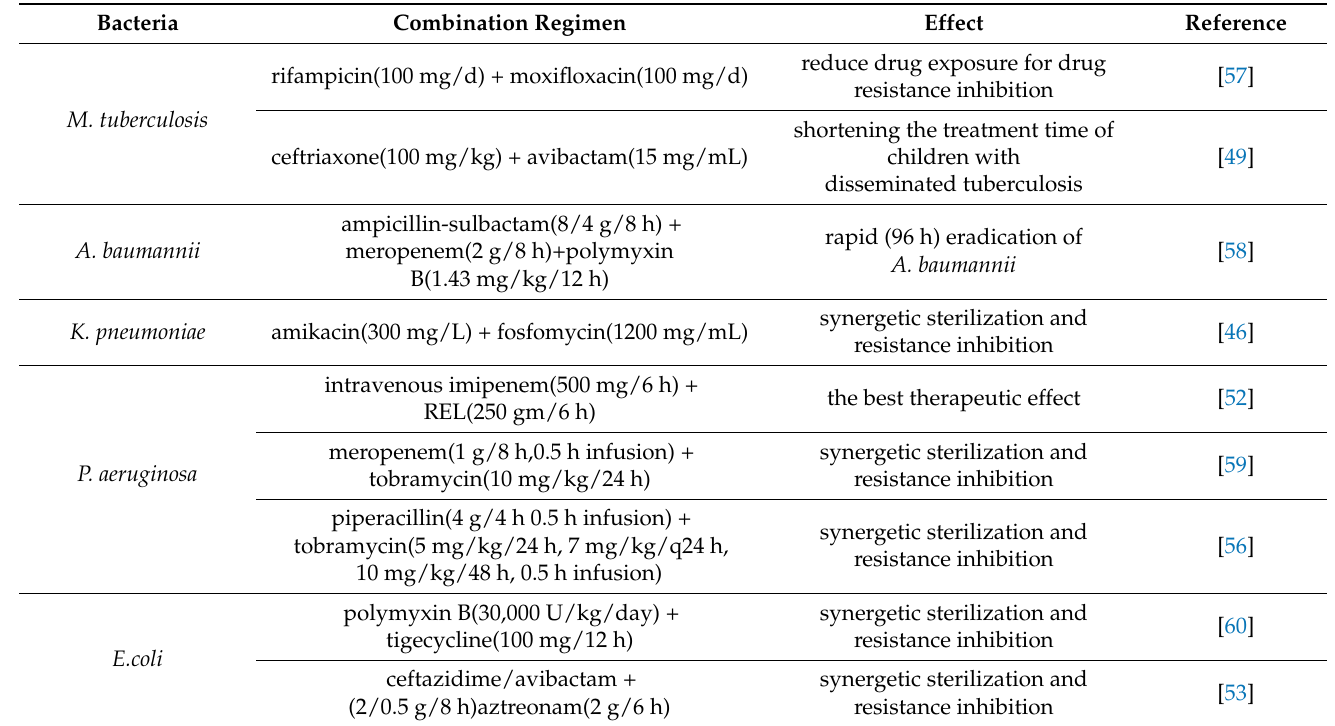
Table 2. Drug Combinations regimen obtained from